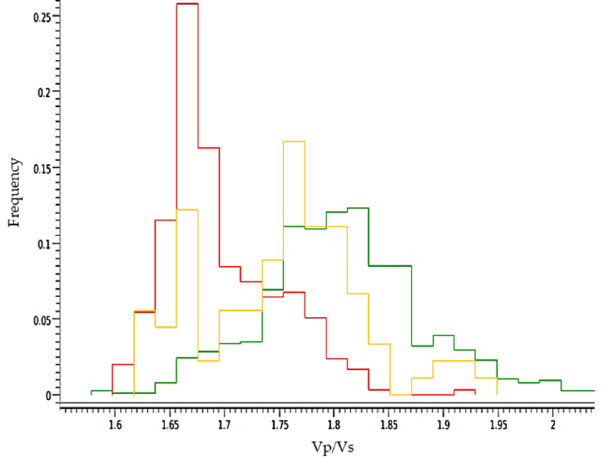
Figure 7. Vp/Vs histogram among gas-layer (red), non-gas layer (green), and target layer (yellow).